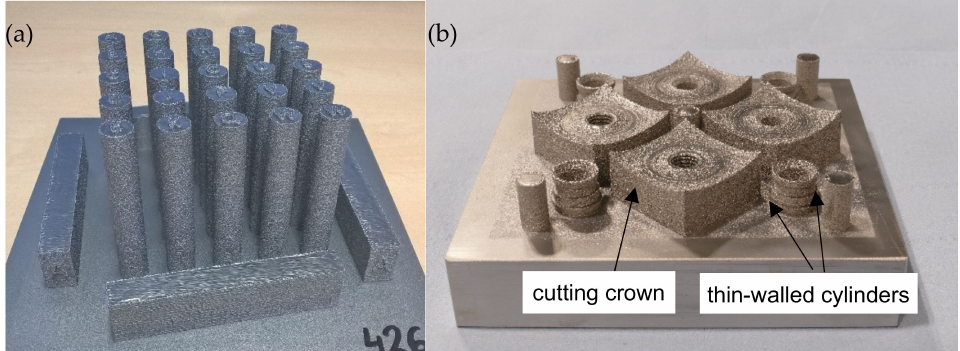
Figure 1. ( a ) PBF-EB printed specimens for mechanical and physical tests; ( b ) demonstrators (cutting crowns and thin-walled open and closed cylinders).